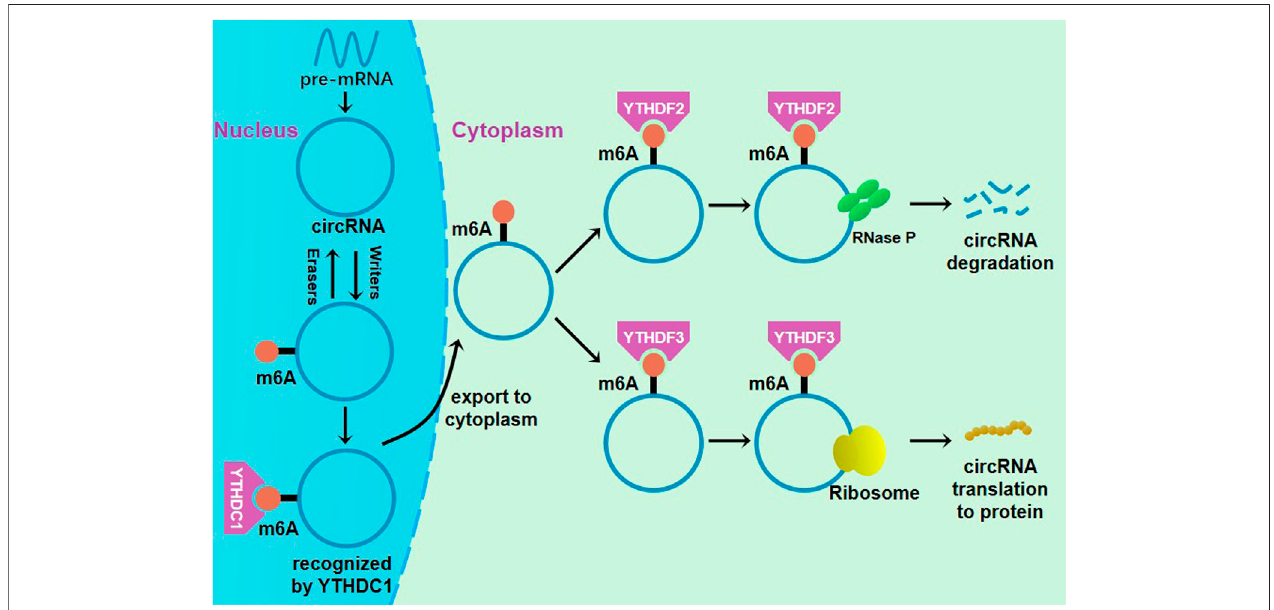
FIGURE 2 | Regulation of m6A methylation in circRNA. YTHDC1 could promote circRNA nuclear export through binding to m6A methylation sites. The complex of eIF4G2, eIF4, eIF4B and YTHDF3 could initiate the translation ofm6A-modi fi edcircRNA, and the circRNA could be cleaved by YTHDF2-HRSP12-RNaseP/MRP complex.